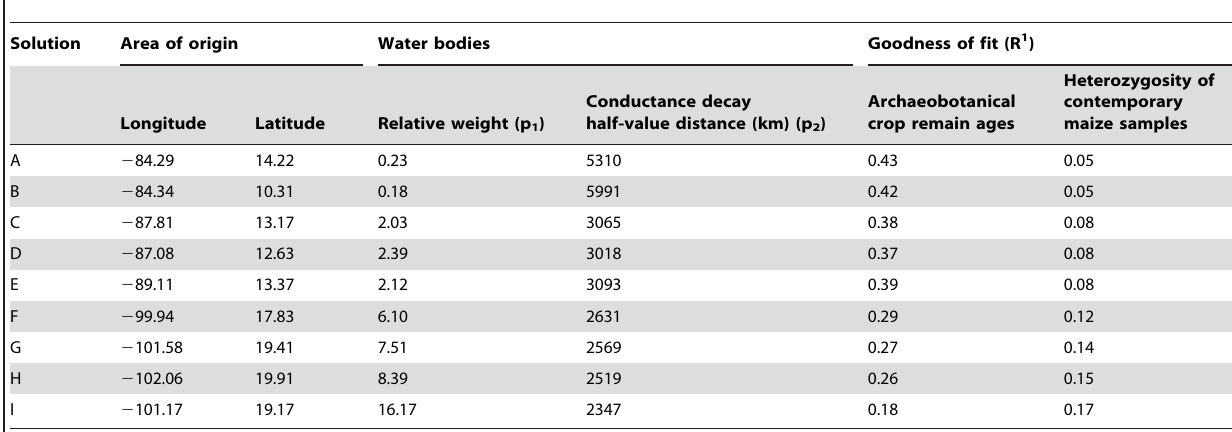
Table 1. Representative selection of Pareto